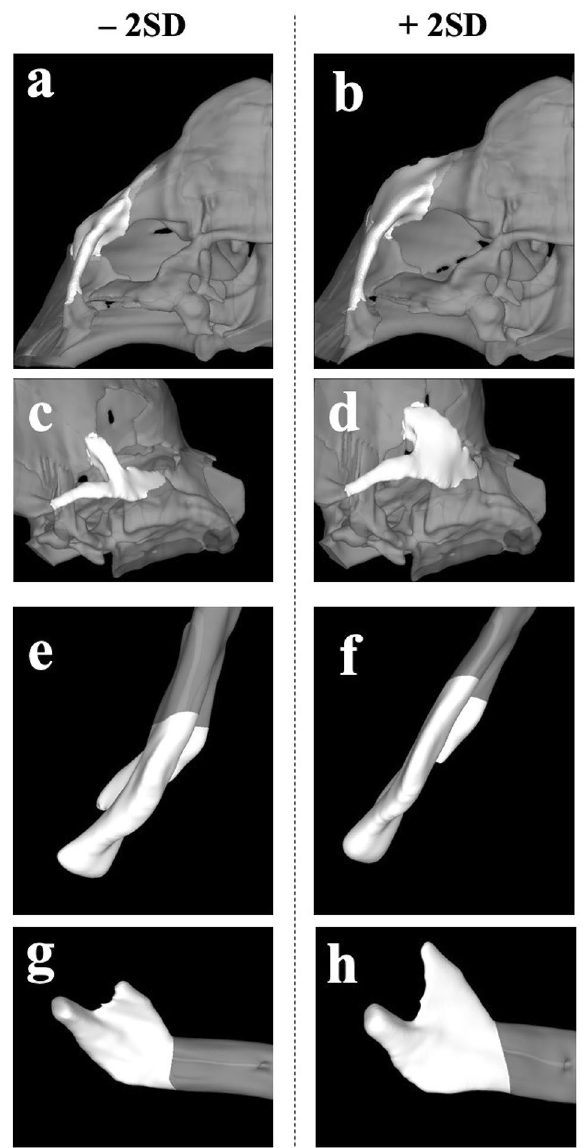
Figure 5. Change in shape in the zygoma and mandibular ramal areas correlated to masseter muscle growth. The shape changes seen in the zygoma ( a – d ) and the ramus of the mandible ( e – h ) along the first singular warp (SW1), on the cross-sectional areas (CSAi) of the masseter muscles from − 2 ( a , c , e , g ) and + 2 ( b , d , f , h ) standard deviations (SD). The body of the zygoma appears to expand in an antero-lateral direction with increasing masseter CSAi ( a , b Inferior view; c , d Lateral-inferior view). The width of the ramus and the coronoid process appears to expand, and the mandibular body shifts laterally with increasing masseter CSAi ( e , f inferior view; g , h lateral